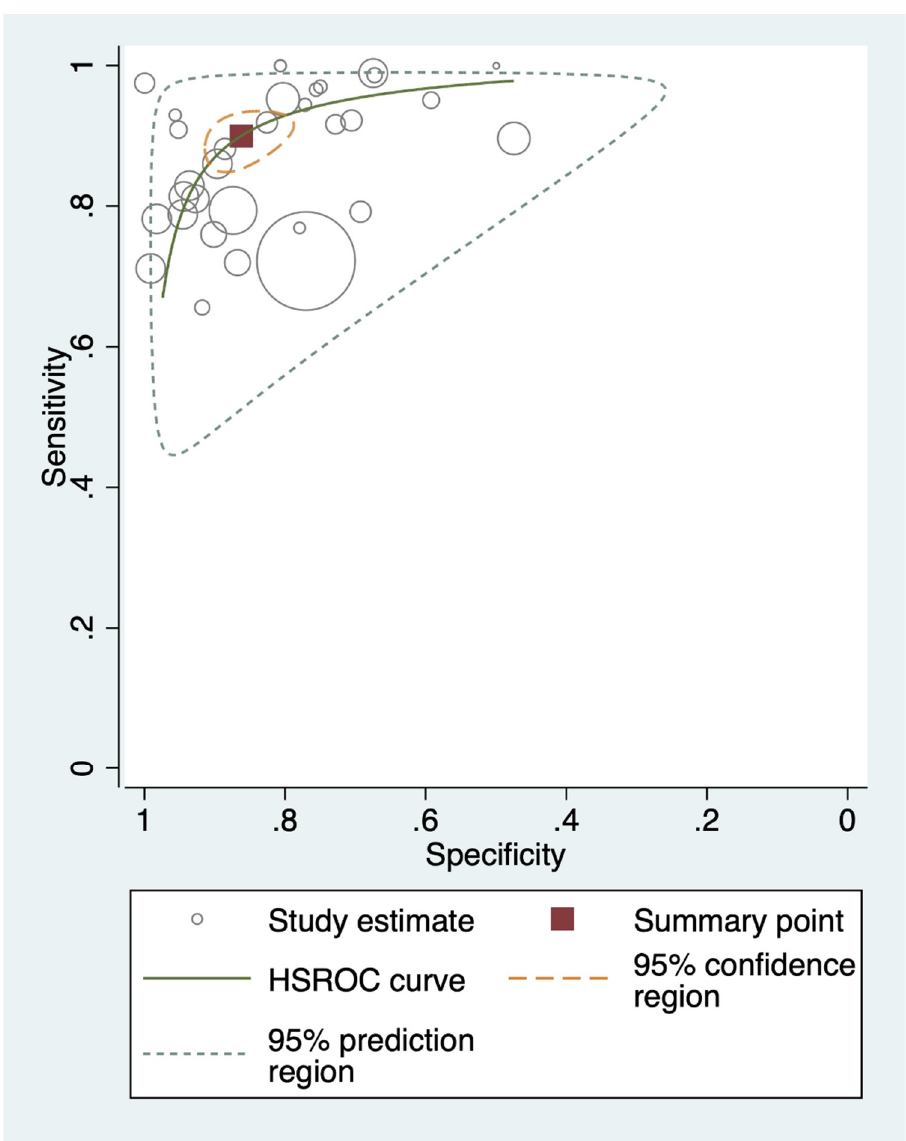
Figure 2. Hierarchical summary receiver-operating characteristic curves of the sensitivity and specificity of cholera rapid diagnostic tests (direct testing of fresh stools). Each circle represents the sensitivity and specificity of each included data point ( n = 32). The summary point refers to pooled sensitivity and specificity. Sensitivity = 90% (95% CI, 86 to 93) and specificity = 86% (95% CI, 81 to 90). GTFCC recommends that cholera RDTs should be at least 90% sensitive and 85% specific. CI = confidence interval; HSROC = hierarchical summary receiver-operating characteristics; GTFCC = Global Task Force on Cholera